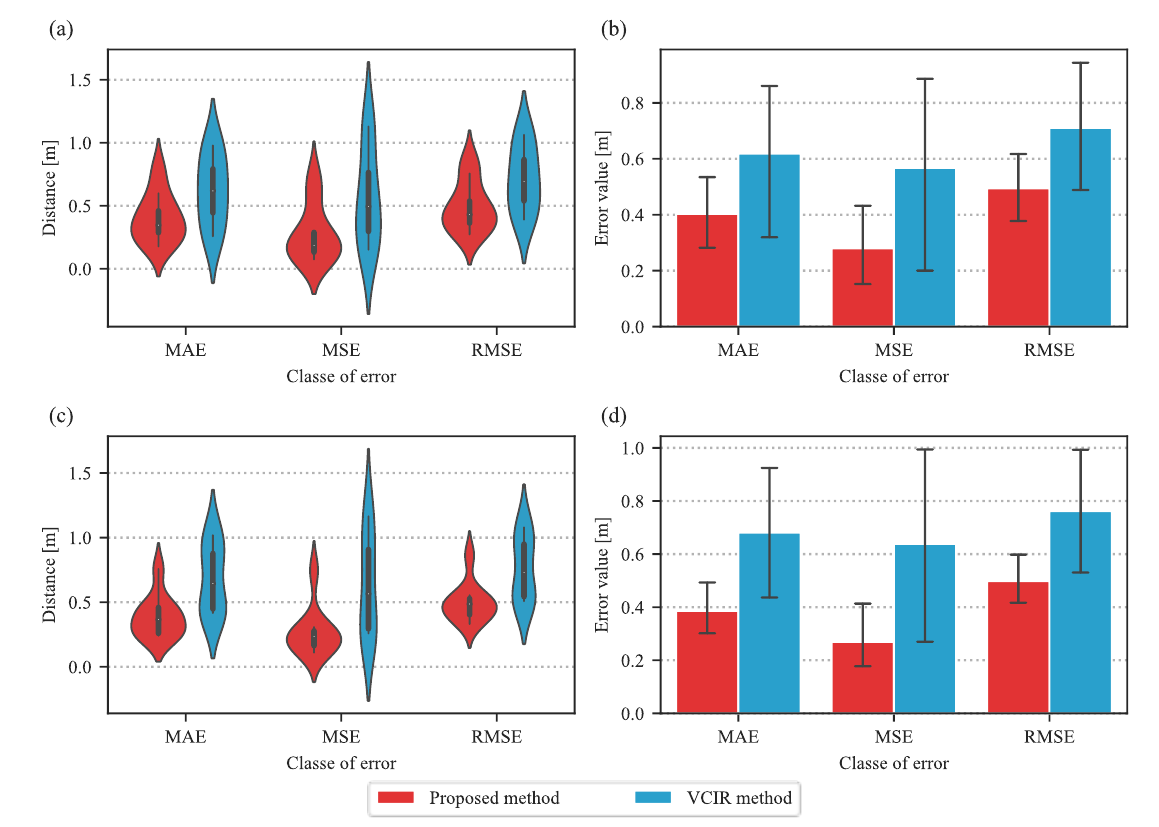
Figure 15. Violin plots and bar plot for the errors of facade extraction for Semantic3D.Net Bench- mark dataset: ( a , c ) violin plots for distances between points and facades for the “domfountain” and “marketplacefeldkirch” scenes, respectively, where the shape of the violin describes the data’s probability density distribution; the black bar describes the interquartile range; the 95% confidence interval is shown by the inner line branching from it; and the median is shown by a white dot; and ( b , d ) bar plots for total errors of the facades for the “domfountain” and “marketplacefeldkirch” scenes, respectively, where the vertical bars show the mean of the data, and the error line shows the 95% confidence interval. Table 3. Errors of facade extraction for the Semantic3D.Net Benchmark